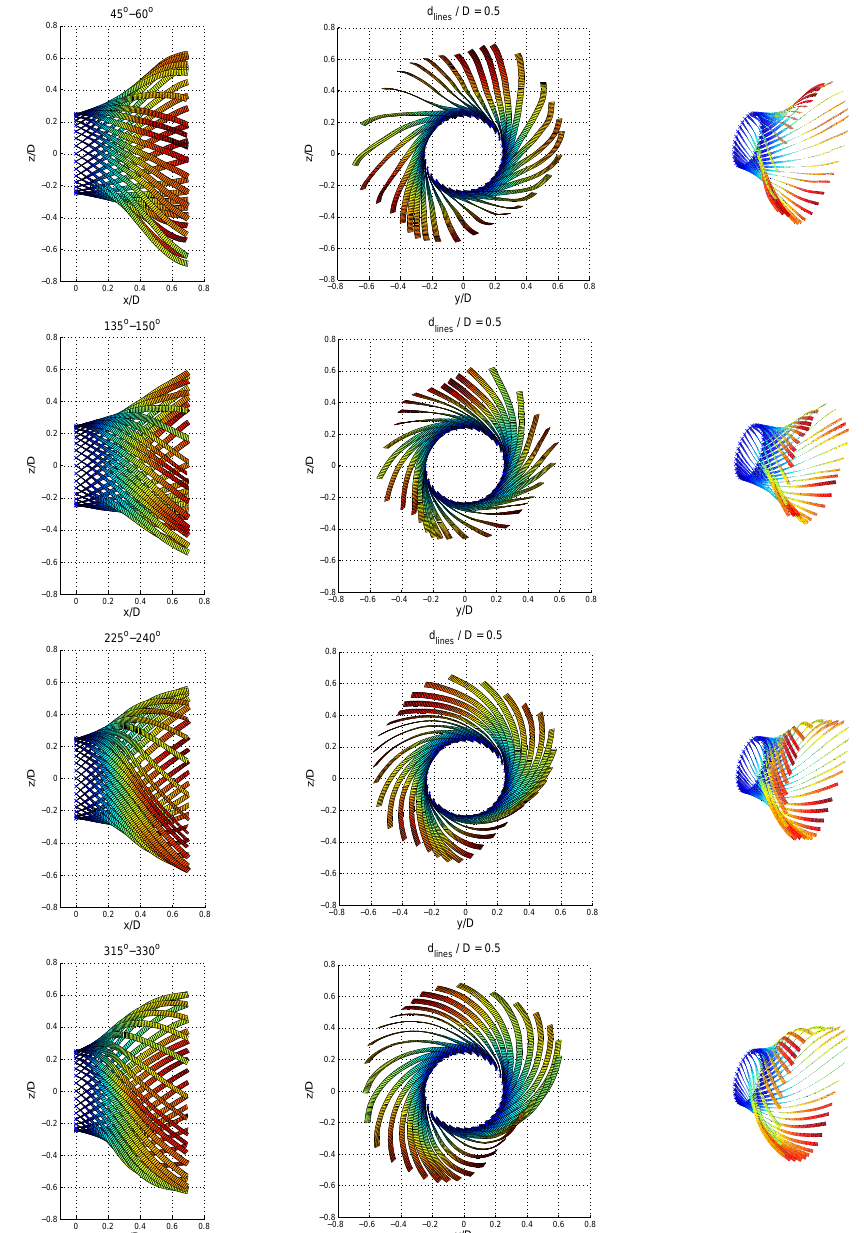
Figure 23. 3D streamlines for free-jet configuration, emitted along a d / D = 1/2 diameter circle placed in the injection section (mixing layer, where the liquid phase is injected). ( Left and middle ): Profile and front views of the 3D streamlines. ( Right ): three-quarter view. Air pulsation 30% of 30 g/s at 100